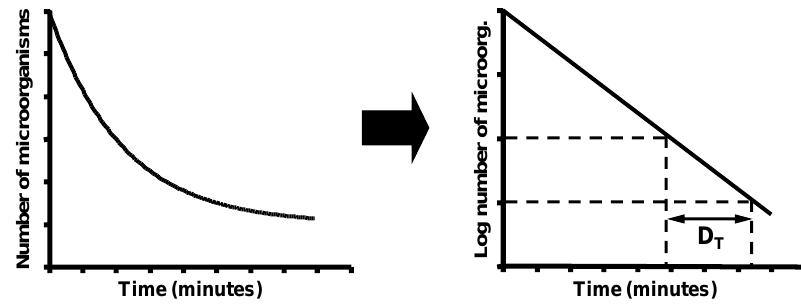
Figure 4. Effect of treatment time on microbial survival to a heat treatment at constant temperature.